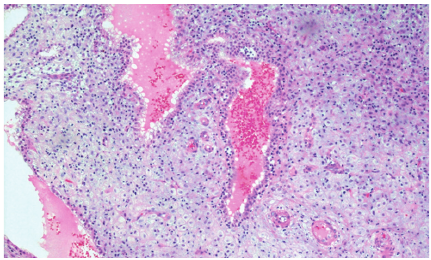
Figure 2: Fallopian tube with decidual change.